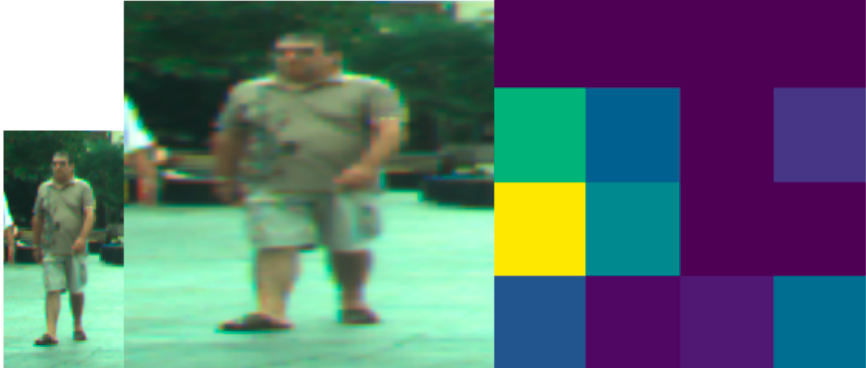
Figure 9. Visual representation of bottleneck features from the VGG-16 model.